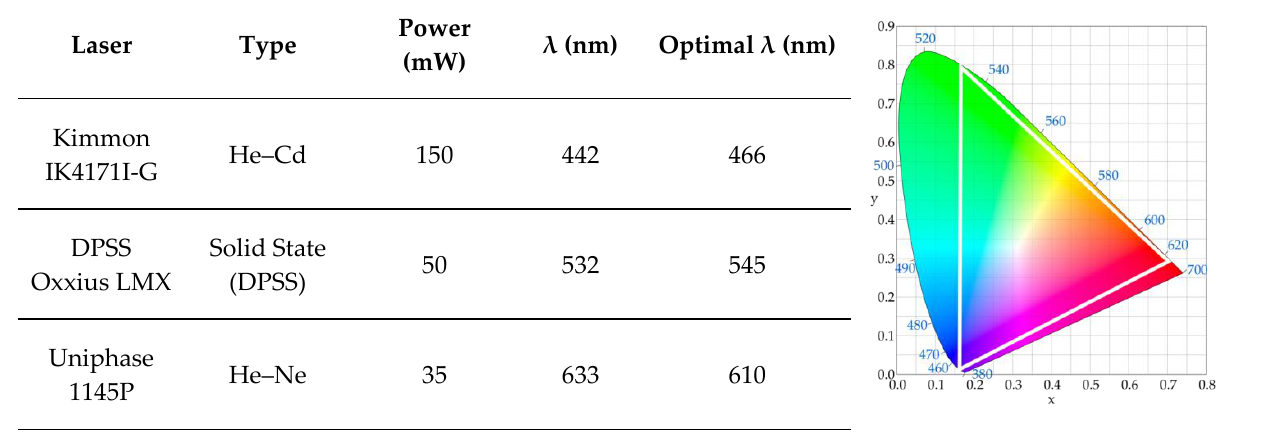
Figure 1. Main characteristics of the lasers used in the recording setup, together with the optimal λ for color reproduction stated in [16]. CIE diagram with the representation of the color reproduction area obtained with the three lasers.